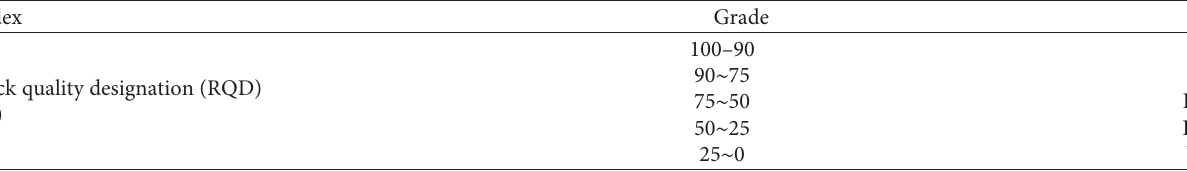
Table 1: Classification system of slope